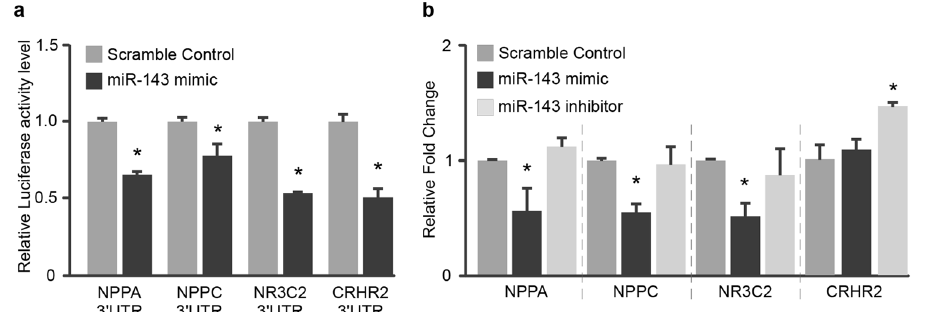
Figure 5. Regulatory effects of miR-143 on the expression of NPPA, NPPC, NR3C2 and CRHR2. ( a ) Luciferase reporter assay to demonstrate the interactions between miR-143 and the 3 ′ UTRs of NPPA, NPPC, NR3C2 and CRHR2. ( b ) Overexpression of miR-143 (miR-143 mimic) suppressed expression of NPPA, NPPC, and NR3C2 in HCMa cells. However, knockdown of NPR3 level with antagomiR-143 did not lead to enhancement of NPPA, NPPC, and NR3C2 levels in HCMa cells. Data are presented as mean ± SD, n = 3, Student’s t test, * p <